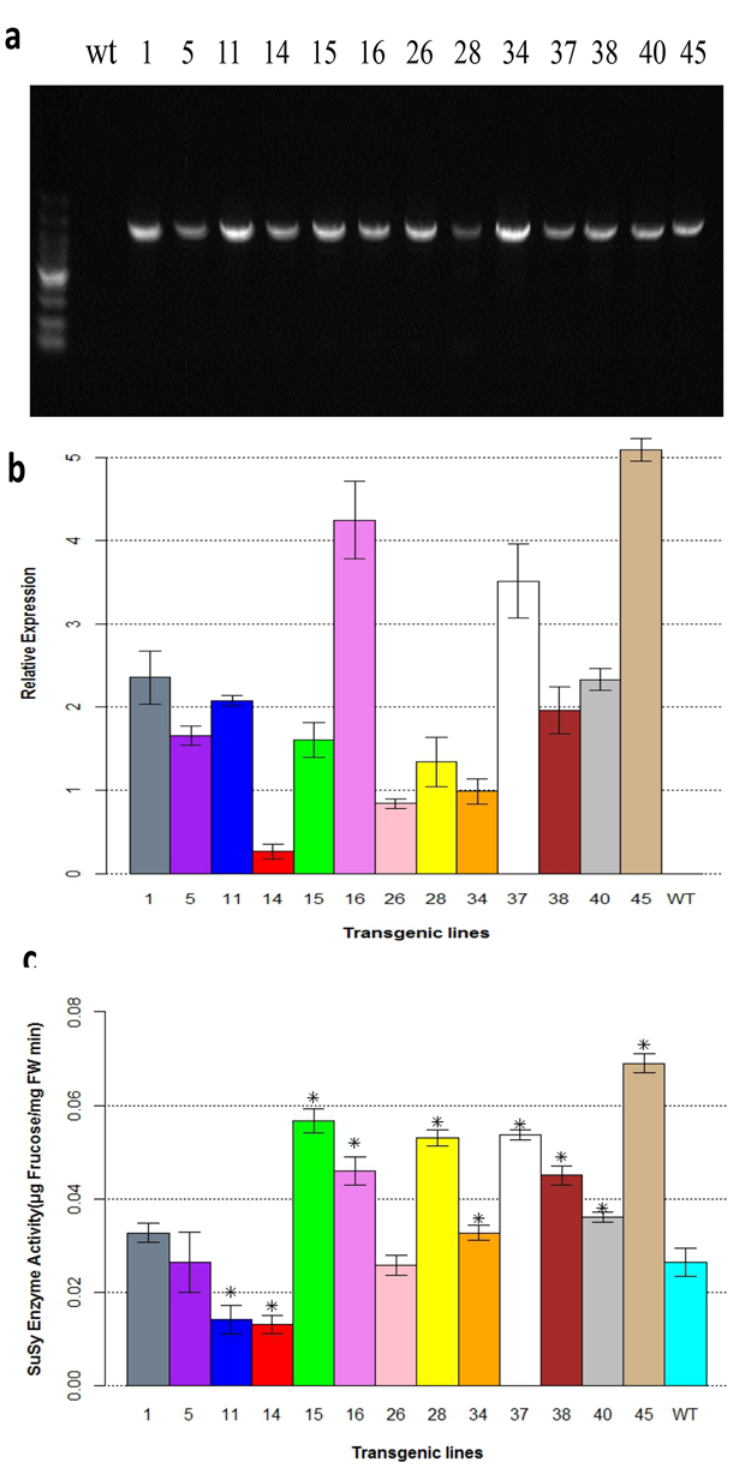
Fig 3. Validation of PsnSuSy2 integration into tobacco genome and expression in transgenic tobacco lines. a. Validation of PsnSuSy2 tobacco transgenic lines using PCR amplification. Genomic DNA was extracted from the leaves of one-month-old transgenic tobacco. The PCR products were electrophoresed on a 1.2% agarose gel with DL15000 DNA marker (first lane). b. Relative expression of PsnSuSy2 in two month- old stem segments of plastichron index (PI) 3 – 5 determined by real-time RT-PCR. C. SuSy enzyme activity